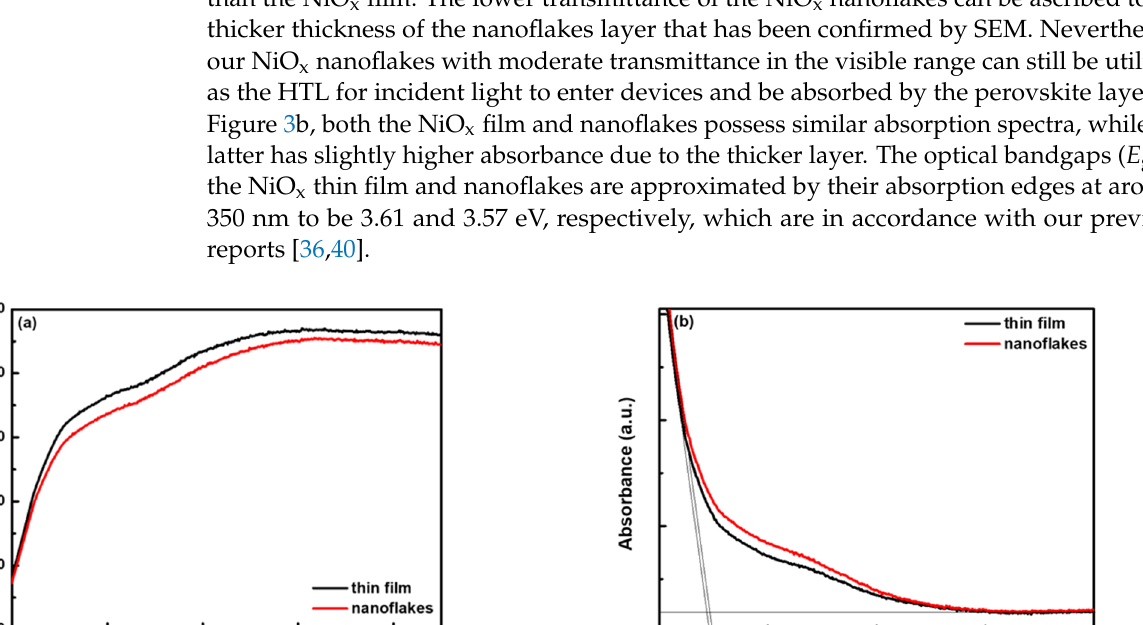
Figure 2. Top-view and cross-sectional SEM micrographs of the NiO x ( a , c ) thin film and ( b , d ) nanoflakes deposited on FTO substrates.